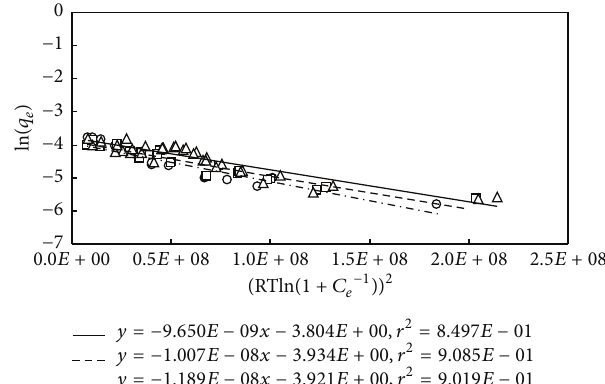
Figure 10: Adsorption of DMP on M-PVAL employing Dubinin- Radushkevich isotherm. Cases with pH 0 = 5, 6.04–6.64, and 7 are expressed as ◻ (--): 𝑦 = −1.007𝐸−08𝑥−3.934 , I (- ⋅ -): 𝑦 = −1.189𝐸− 08𝑥 − 3.921 , and △ (—): 𝑦 = −9.950𝐸 − 09𝑥 − 3.804